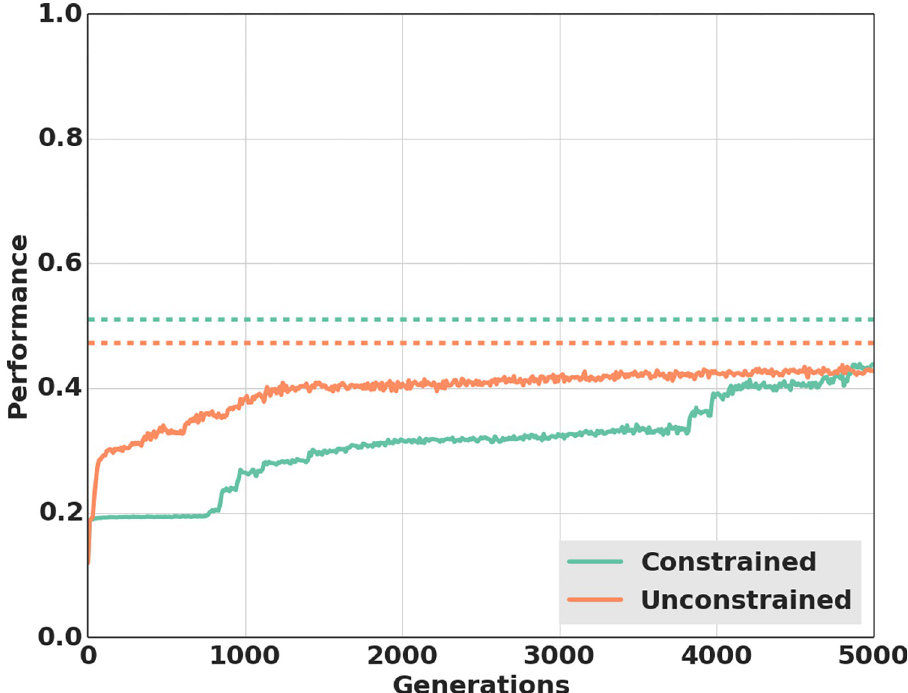
Fig 7. Average performance in the first 5’000 generations of evolutions depending on treatment. Average performance in the unconstrained treatment (40 populations) and in the constrained treatment (40 populations) over the first 5’000 generations. In the constrained treatment, senders where forced to move at a fixed velocity, thus preventing the use of signal onset-delay and/or duration by receivers. Dashed lines show the average performance achieved in the two treatments at the end of the experiments (i.e., at generation